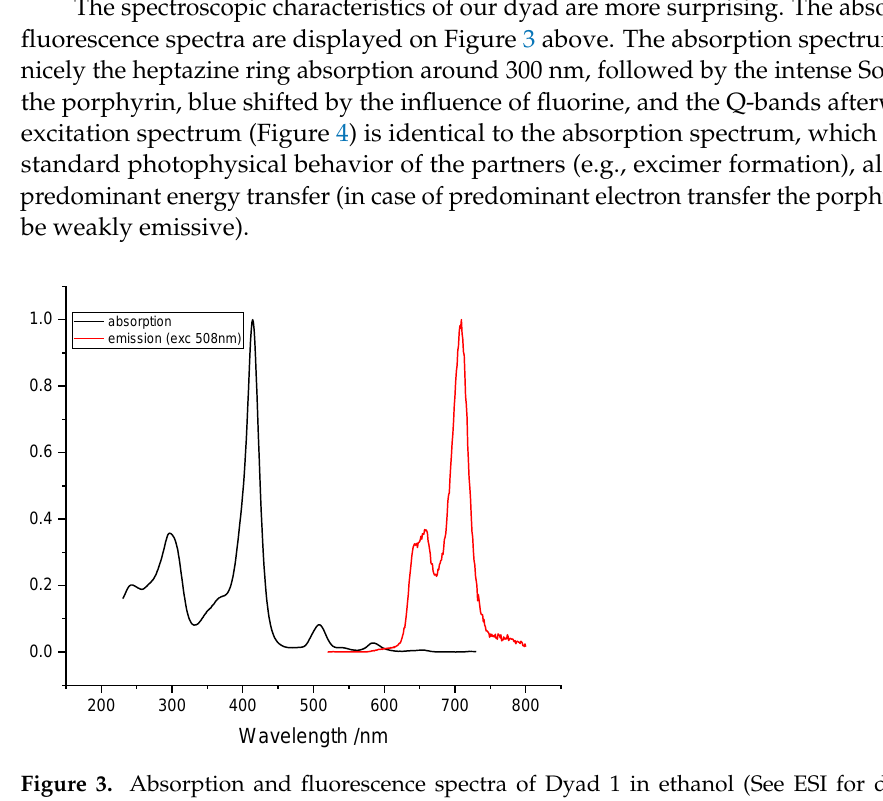
Figure 4. Excitation spectrum of dyad 1 in DCM at 710 nm. On the other hand, the emission spectrum displays almost only the porphyrin emis- sion at 720 nm, but with a lower quantum yield (QY) of 0.03. Comparison with the generic tetrakis-pentafluorophenylporphyrin (2H-20F-TPP) shows an approximate 6% QY, while the emission wavelength remains practically the same (700 vs. 720 nm) [24,25]. These com- bined results show: (1) that the heptazine emission is totally quenched by transfer pro- cesses, and (2) that the decreased emission QY demonstrates that energy transfer is not the sole process since the very similar tris-(perfluorophenyl)-porphyrin alone displays a twofold QY decrease. It is likely to suppose that a concurrent electron transfer (SET) from the heptazine to the porphyrin occurs to some extent, and this is supported by the com- parison of the oxidation potentials of the porphyrin and the heptazine’s excited state. Actually, promotion of electron vs. energy transfer in Dyad 1 is reasonable, since the redox potential of 2H-20F-TPP has been measured of +1.52 V, very close to our measure- ments on Dyad 1, of approx. +1.51 V (+1.25 V vs. Ag/AgCl ref. check ESI Figure S10), the structural difference between the generic 2H-20F-TPP being minor. On the other hand, the redox potential in the excited state E Hp * of the substituted heptazine can be estimated (through Rehm- Veller’s approach) of E Hp * = − 1.3 V + 3.85 V = + 2.55 V (1.3 V being the measured reduction potential for the heptazine ring, and 3.85 nm estimated value of the heptazine bandgap, taking the E 0-0 at the onset of the spectra at 320 nm.) vs. SCE, which comes to about 2.8 V vs. NHE (Assuming a 0.24 V difference between the SCE and the NHE.). This high value explains probably the strong competition between electron vs. en- ergy transfer, despite the fact that roughly half of the porphyrin ring fluorescence is re- tained. Another clue of the fact that electron transfer occurs, but to a limited extent, is the comparison of the emission spectra between two solvents of different polarities and die- lectric constants, dioxane and DCM (ESI Figures S13 and S14). The remaining heptazine fluorescence is higher in DCM, as a probable consequence of a less efficient PET in this solvent. For sake of comparison, we have in addition also prepared a molecule with exactly the isoelectronic heptazine core (featuring one primary amine and two pyrazoles) the 1,2-